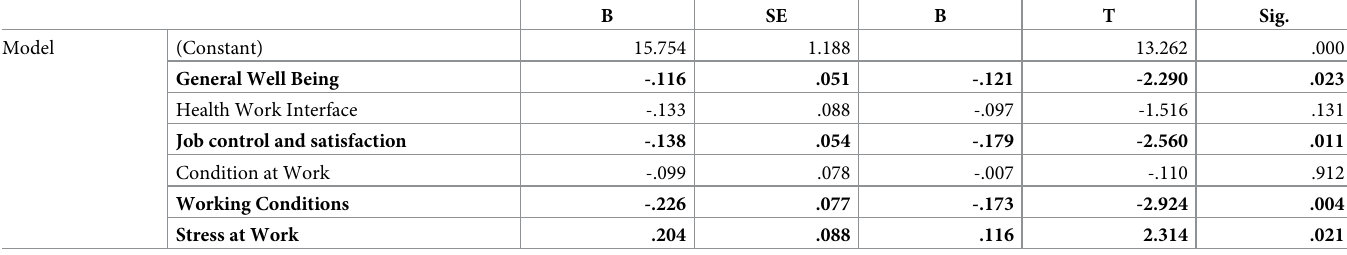
Table 5. Predictors of turnover intentions among